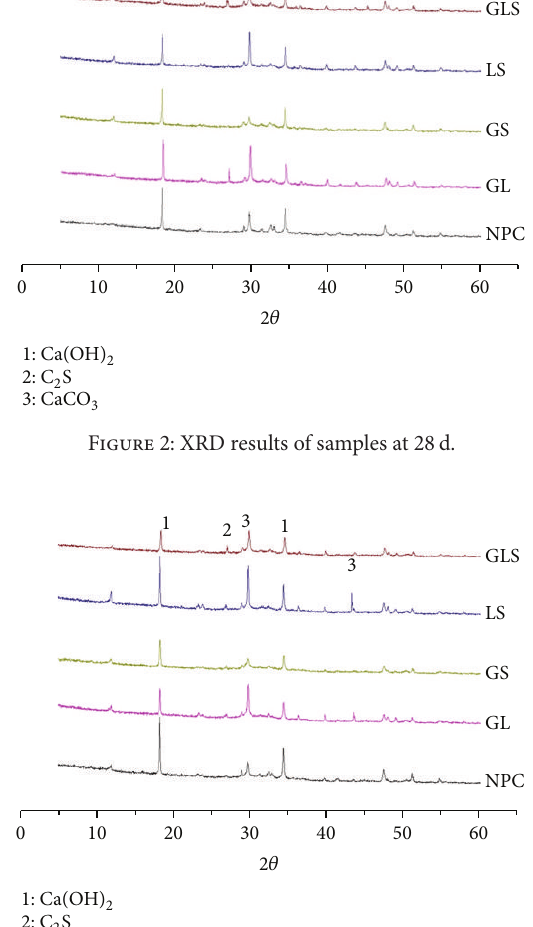
Table 6: Contribution rates of the hydration activity effect. Samples